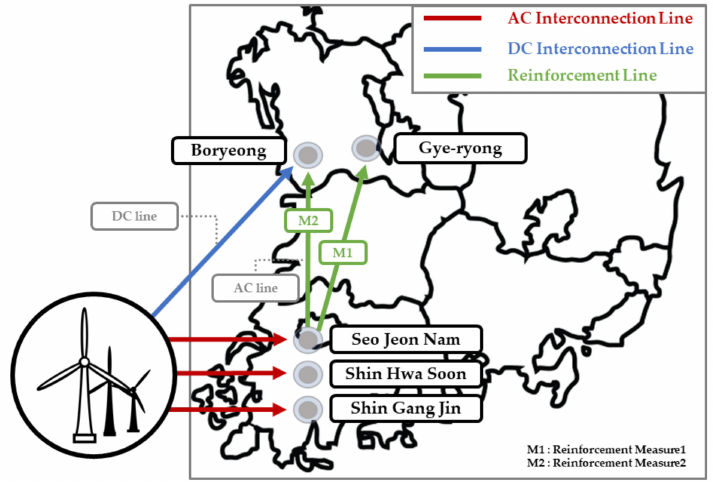
Figure 7. System diagram according to interconnection lines and reinforcement